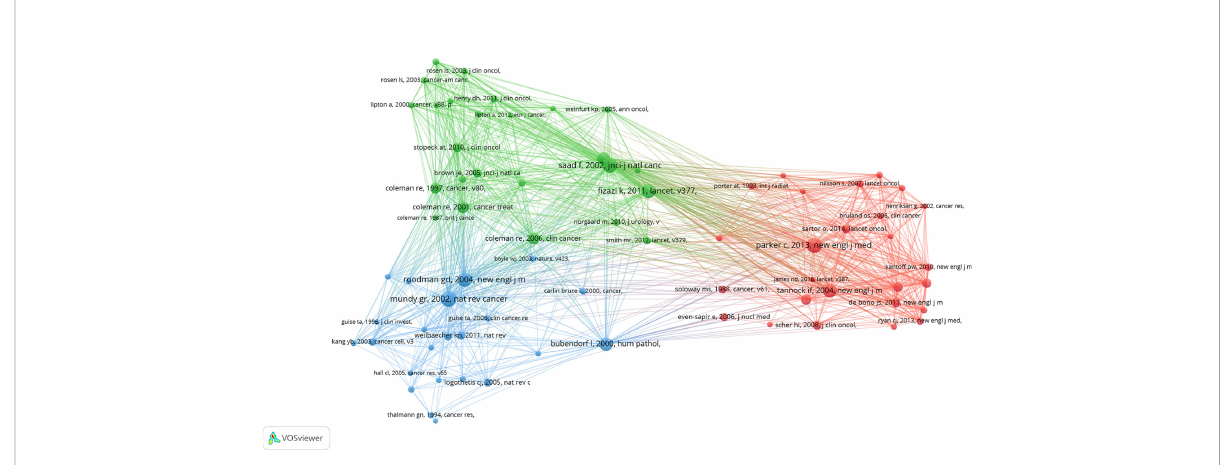
FIGURE 7 Co-cited reference collaboration network visualized by